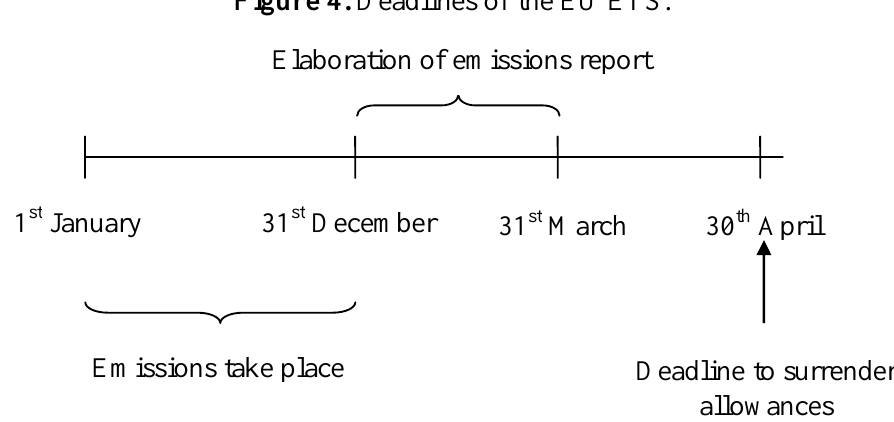
Figure 4. Deadlines of the EU